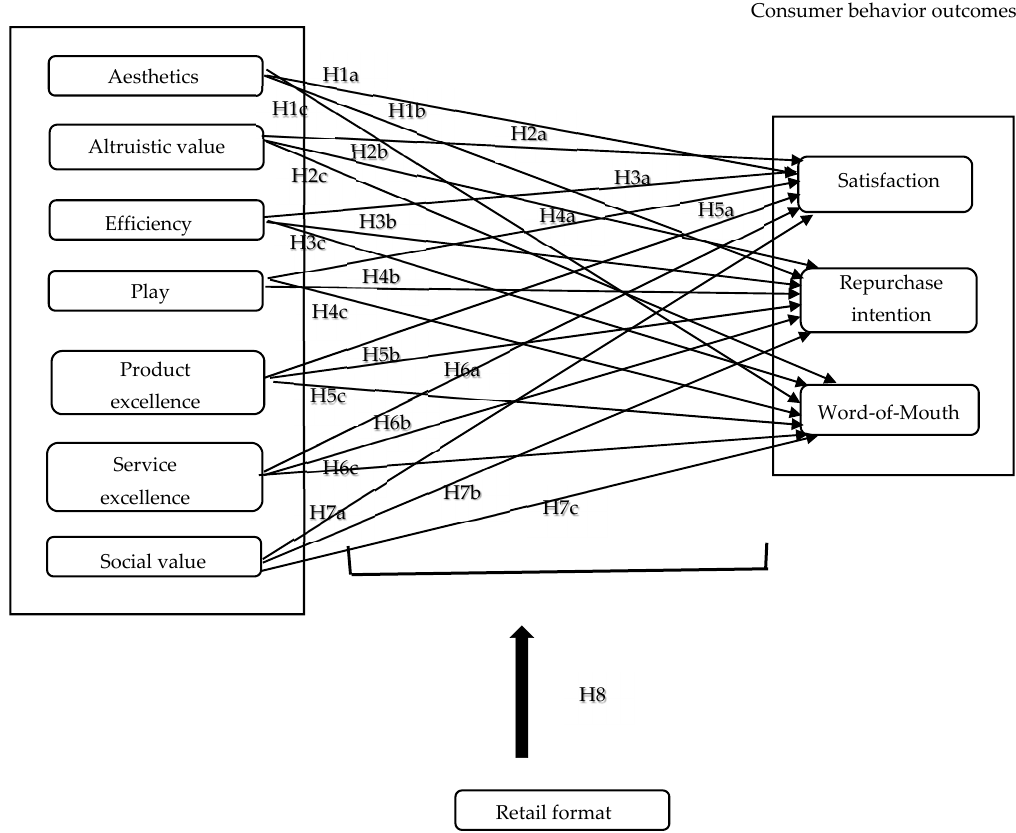
Figure 1. Conceptual model (based on [7]).